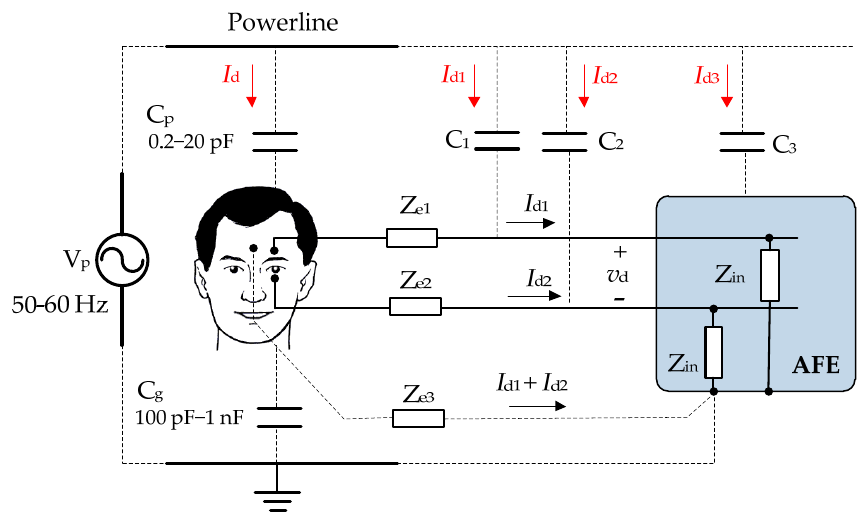
Figure 6. Capacitive coupling between the electrical network and the user.